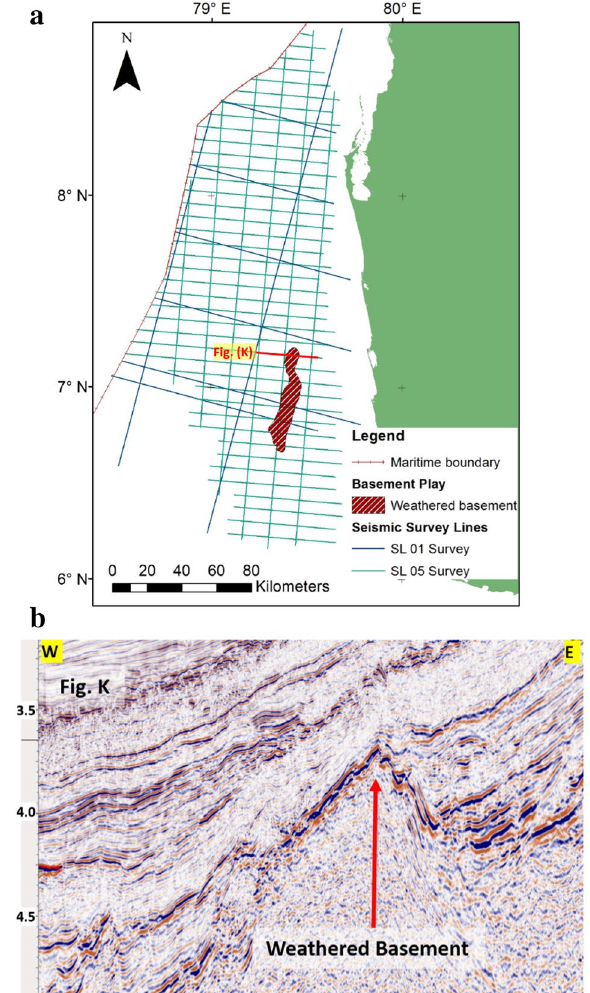
Fig. 14 a Map showing the distribution of the basement plays in the Mannar Basin. b Seismic profile showing the basement play, (K) weathered